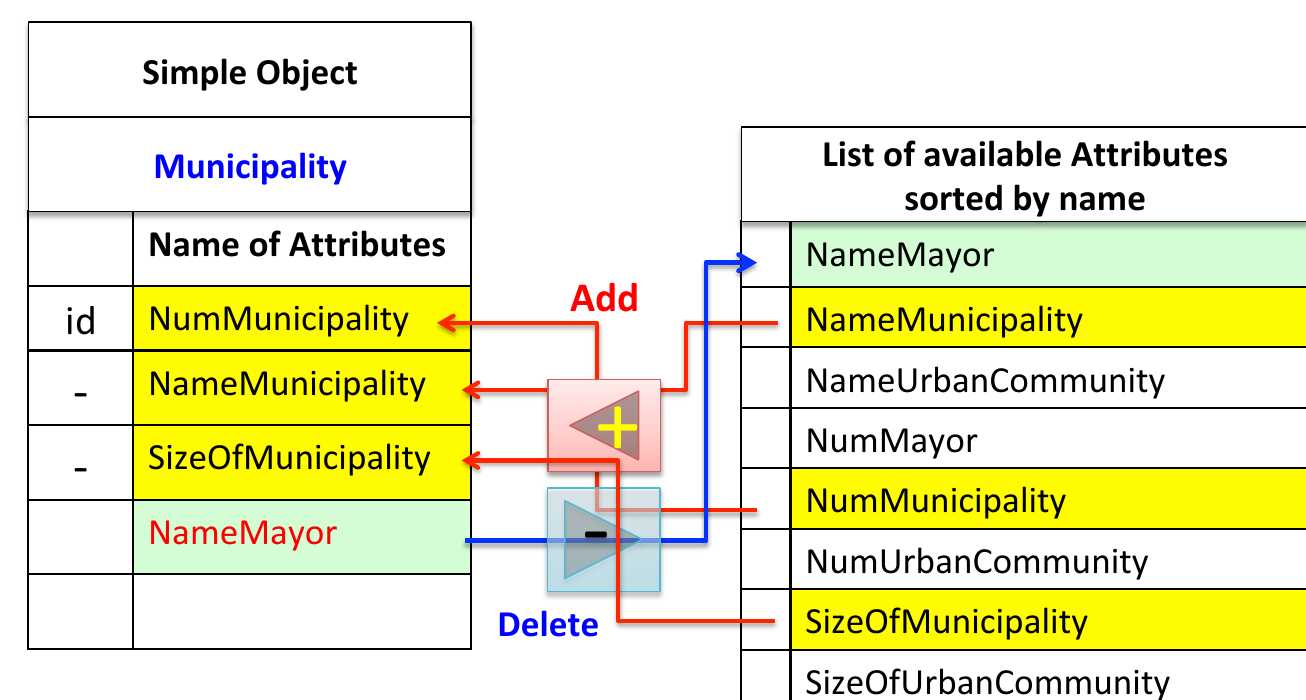
Figure 8. Object type descriptor interface (OTDI).